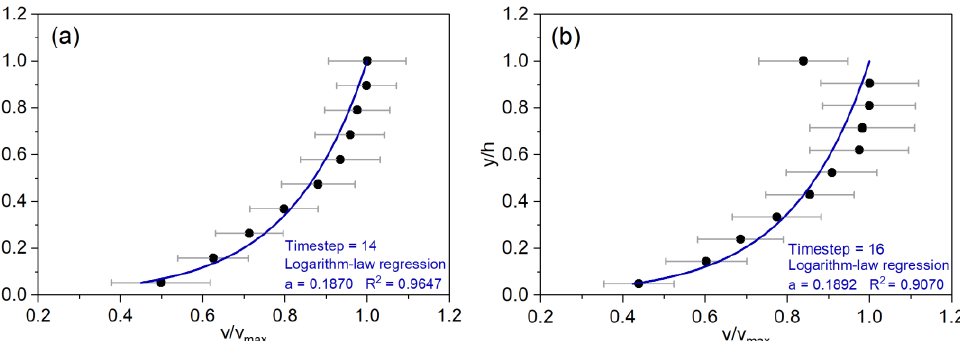
Figure 6. Velocity profile fitting regression analysis. ( a ) Regression analysis of velocity profile at timestep = 14. ( b ) Regression analysis of velocity profile at timestep = 16.